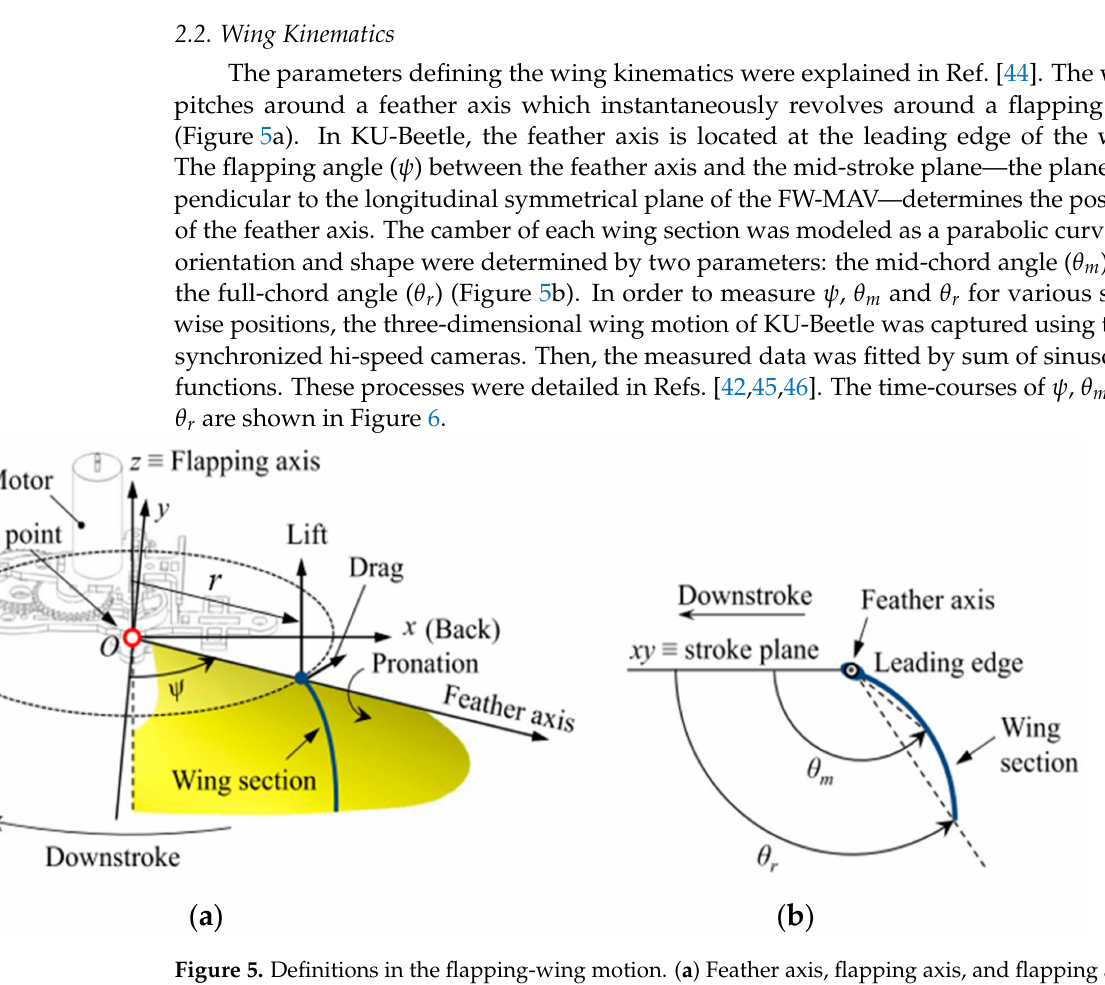
Figure 4. Wing configuration. Reprinted from Ref. [42].